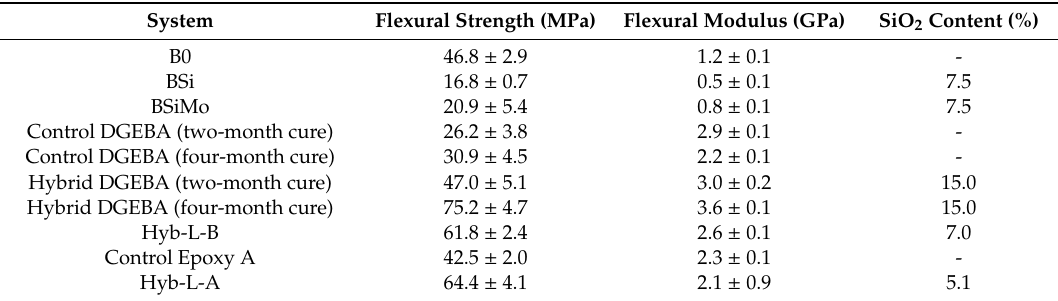
Table 2. Mechanical properties measured in flexural mode at ambient temperature on cold-cured hybrid / non-hybrid